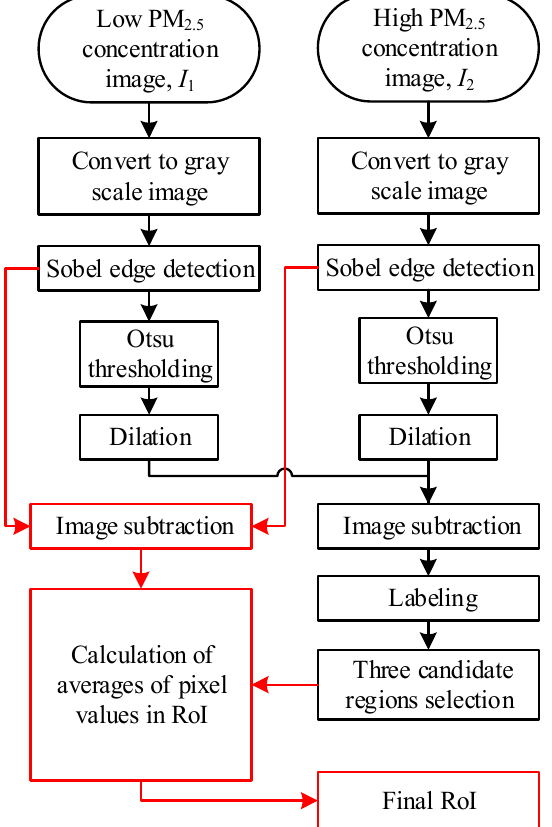
Figure 2. A flowchart of the proposed automatic region of interest (RoI) selection.